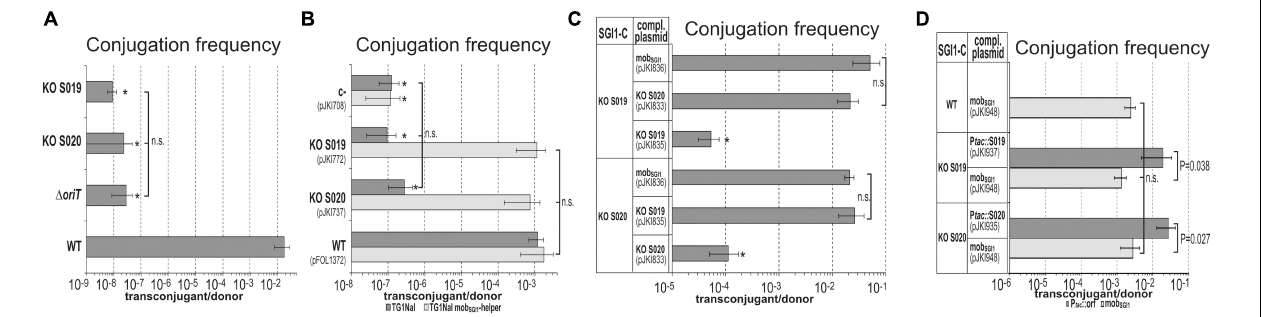
FIGURE 3 | Mutation and complementation analysis of S019 and S020. (A) Transfer frequency of SGI1-C KO mutants. SGI1-C WT and the KO mutants were mobilized by the R55 (cid:49) Tn 6187 helper plasmid from TG1Nal strain into TG2 recipient. The asterisk indicates that the transfer frequency was close to the detection limit. In case of SGI1-C (cid:49) oriT the high rate of co-transfer with R55 among the sporadically occurring transconjugants refers to an oriT SGI1 -independent way, while transconjugants of KO S019 and S020 SGI1-C mutants did not contain the helper plasmid and might derive via a yet unexplored way of in trans mobilization or lost the helper plasmid after conduction. (B) Transfer frequency of S019 and S020 KO mutant mob SGI1 regions cloned in pJKI708. In the mating assays TG1Nal/R55 or TG1Nal::mob SGI1 /R55 strains containing the KO mutant or control plasmids were used as donor strains and TG2 was the recipient. Basal level of plasmid transfer (including the negative control plasmid pJKI708) indicated by asterisk did not result from regular in trans mobilization (high co-transfer rate with R55). (C) Trans -complementation of SGI1-C (cid:49) S019 and SGI1-C (cid:49) S020 by the respective KO mutant mob SGI1 regions. Donor E. coli strains TG1Nal::SGI1-C (cid:49) S019 and TG1Nal::SGI1-C (cid:49) S020 carried the helper plasmid R16a and one of the complementing plasmids containing the WT, KO S019 or KO S020 mob SGI1 region (pJKI836, pJKI835or pJKI833, respectively). ∗ Transconjugant frequency was below or around the detection limit. The relatively high detection limit was due to the lower donor titers compared to other matings (1.2–8.2 × 10 6 CFU/ml instead of the general 2–5 × 10 9 CFU/ml) in this experimental setup that was caused by the presence of two plasmids along with SGI1 in the donor strains. (D) Trans -complementation of SGI1-C (cid:49) S019 and SGI1-C (cid:49) S020 by expression of S019 or S020 proteins. Mating assays were performed using the recipient strain TG2 and donor strains TG1Nal::SGI1-C WT , TG1Nal::SGI1-C (cid:49) S019 , or TG1Nal::SGI1-C (cid:49) S020 harboring the helper plasmid R16a and one of the complementing plasmids: pJKI948 contained the mob SGI1 region, while pJKI937 and pJKI935 expressed S019 and S020, respectively, from P tac promoter. Protein expression was driven by leakage of the tac promoter (without IPTG induction).